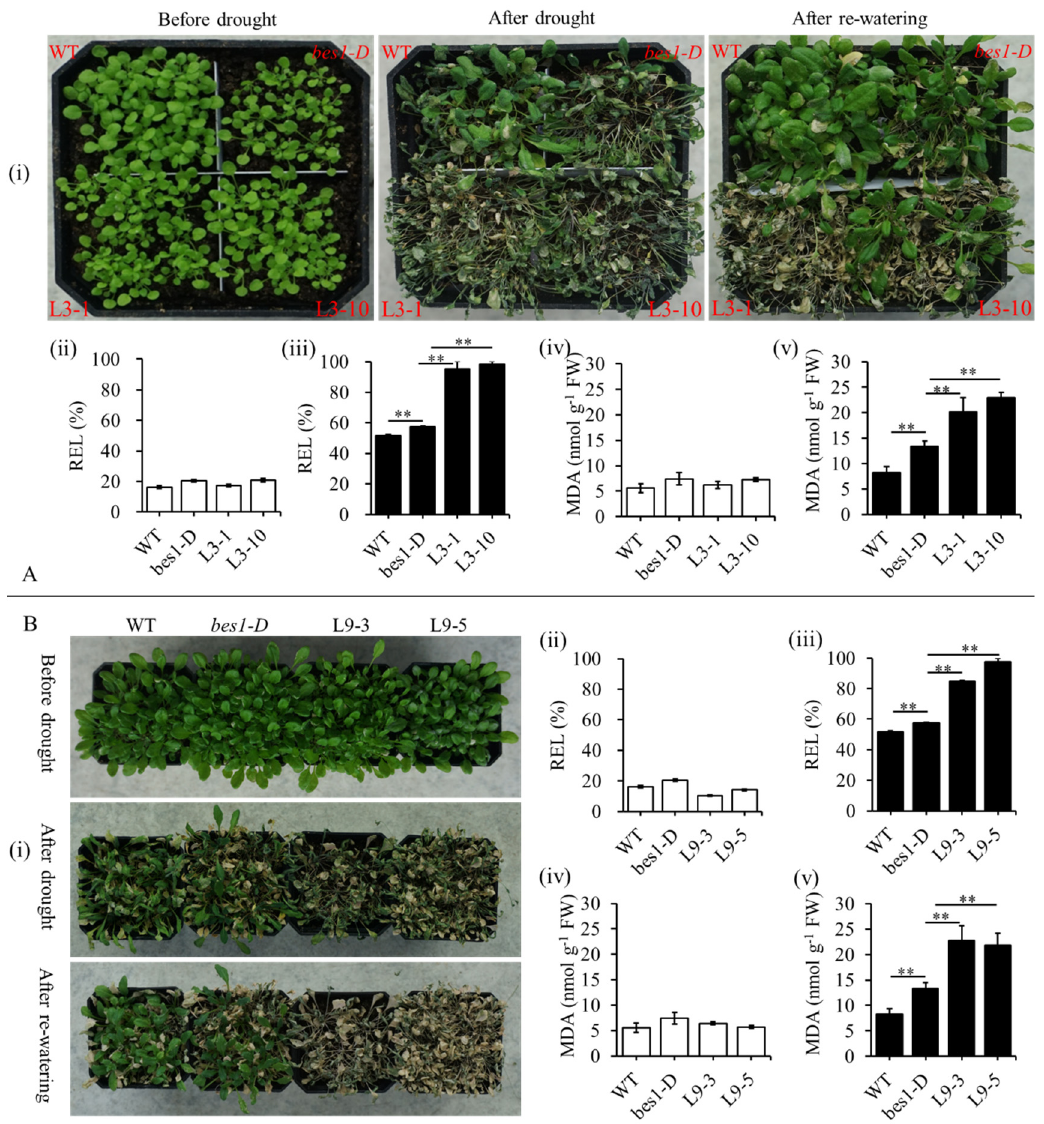
Figure 5. The phenotype of transgenic plants under the drought treatment. ( A ) The phenotype of the ZmBES1/BZR1-3 expressing lines. ( B ) The phenotype of the ZmBES1/BZR1-9 expressing lines. ( i ) The phenotype, ( ii ), ( iv ) the REL and MDA content before treatment, respectively. ( iii ), ( v ) The REL and MAD content after treatment, respectively. The seeds of every line were planted on the soil, cultured in the chamber, and irrigated at 4-day intervals. The 20-day-old seedlings were used for the drought treatment by holding water and subsequently monitored for the stress symptoms for three weeks. All of the values are means (±SD) of three biological replicates. L3-1, L3-10, L9-3, and L9-5 are transgenic lines; bes1-D , mutant. WT, wild type. ** represents p < 0.05 and p < 0.01, respectively. The above results indicate that the expression of the ZmBES1/BZR1-3 and ZmBES1/BZR1- 9 genes both decrease the drought tolerance in transgenic Arabidopsis